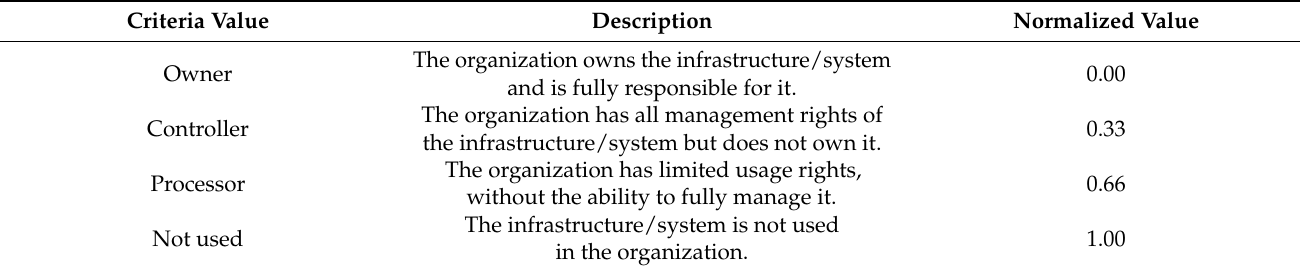
Table 4. Criteria value association to normalized value for sub-criteria information technology management